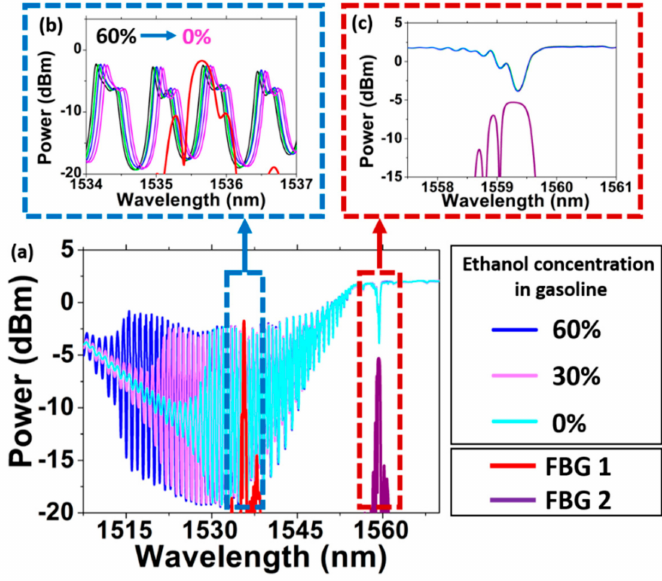
Figure 1. ( a ) Spectral response of the fiber Bragg gratings (FBG 1 and FBG 2) and of the tilted Bragg grating when it is immersed in the gasoline–ethanol solutions of di ff erent concentrations. Zoomed-in view of the spectral ranges ( b ) between 1534 nm and 1537 nm and ( c ) between 1557.5 nm and 1551